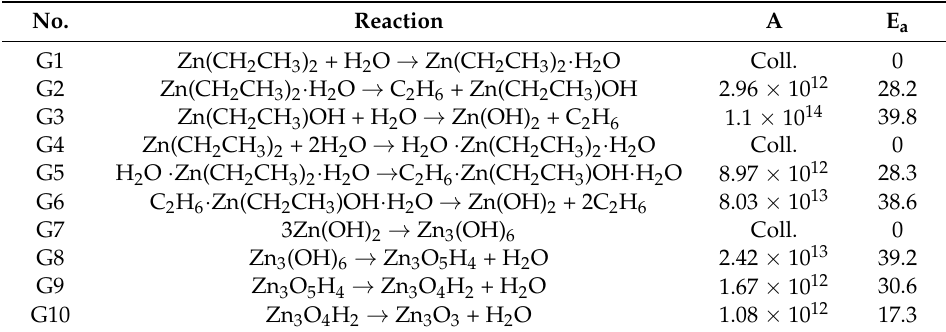
Table 1. Gas-phase reaction pathways and kinetic parameters of diethylzinc (DEZn) hydrolysis. No. Reaction